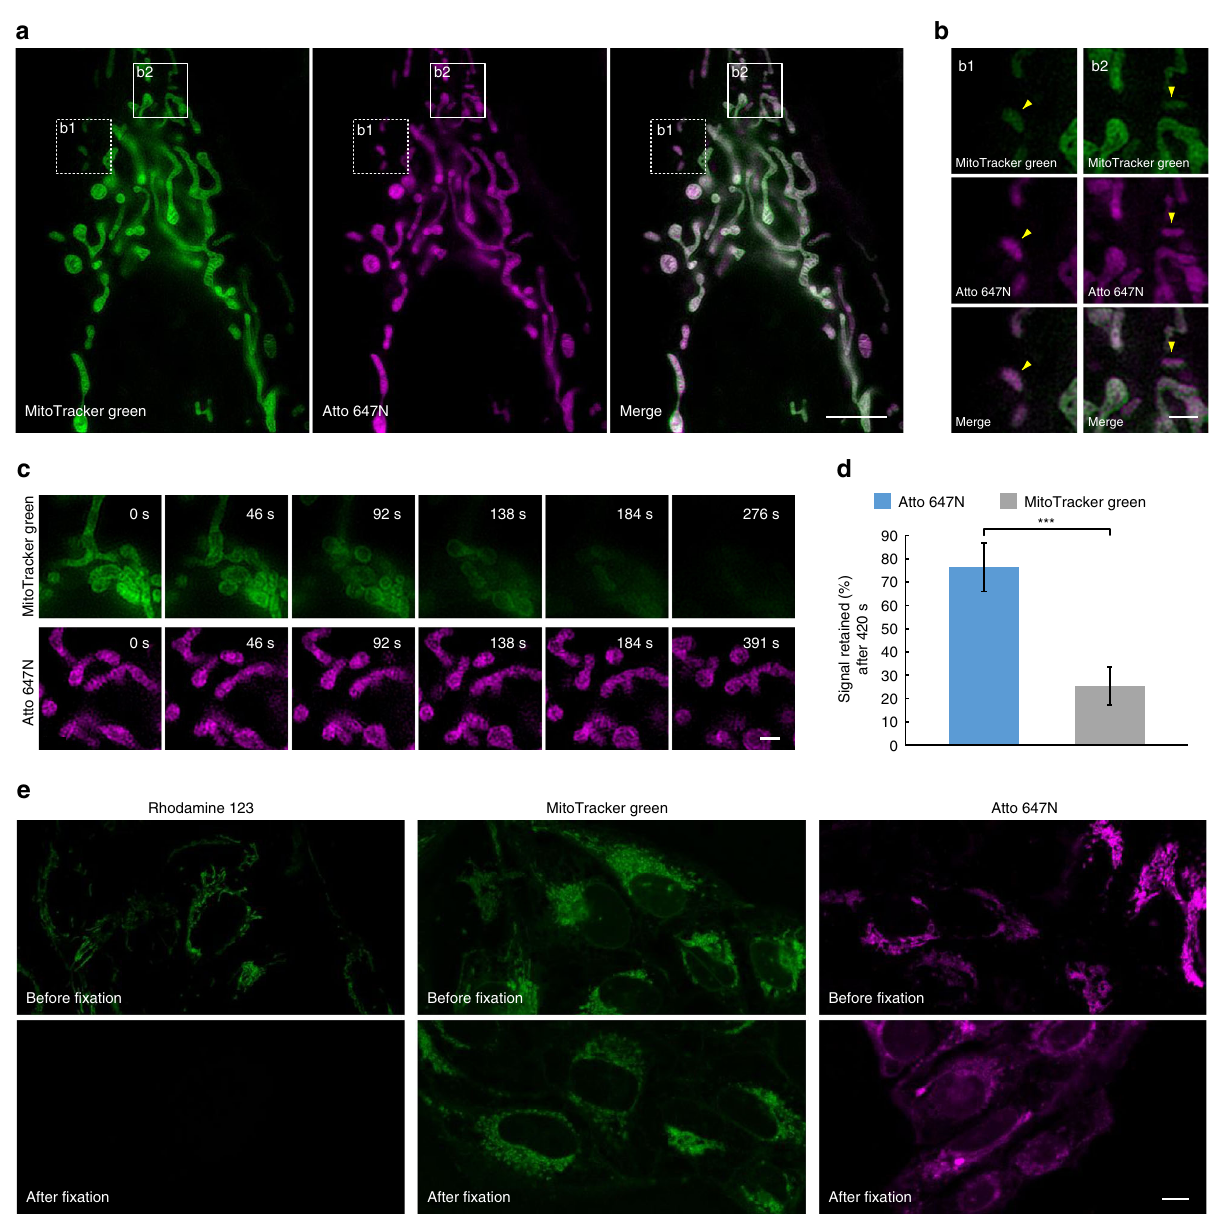
Fig. 2 Characterization of Atto 647N in live cells. a A co-localization study employing MitoTracker Green as the standard mitochondrial marker. Live U2OS cells were simultaneously stained with MitoTracker Green (green, 400 nM) and Atto 647N (magenta, 15 µ M) for 30 min and imaged by SIM. b Enlargements of the boxed regions in a . c Time-lapse SIM images of live U2OS cells stained with MitoTracker Green (green, 400 nM) or Atto 647N (magenta, 15 μ M). d The percentage of retained fl uorescence intensity of Atto 647N and MitoTracker Green after 420 s of time-lapse SIM imaging (from n = 10 areas, mean ± s.d.; *** P < 0.0001, two-tailed t-test; statistics were performed using SPSS 19.0 software package (IBM Co.)). e Confocal images of U2OS cells stained with Rhodamine 123 (2 µ M), MitoTracker Green (400 nM), or Atto 647N (15 µ M) before and after cell fi xation. Each SIM frame was acquired over 270 ms (i.e., a raw data exposure time of 30 ms). For the time-lapse images, consecutive SIM frames spaced at ~ 1.15-s intervals were obtained; representative images of consecutive SIM frames are displayed. Scale bars, a 5 μ m, b , c 1 μ m, and e 10 μ